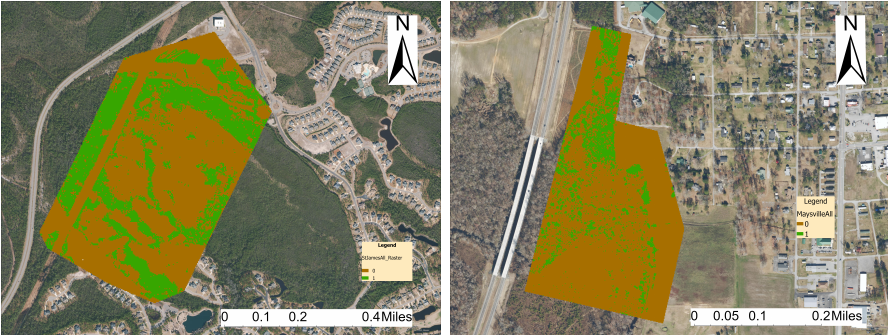
Figure 12. XGBM classification model for the StJames pooled Leave-One-Site-Out ( left ) and XGBM classification model for the Maysville pooled Leave-One-Site-Out ( right ).